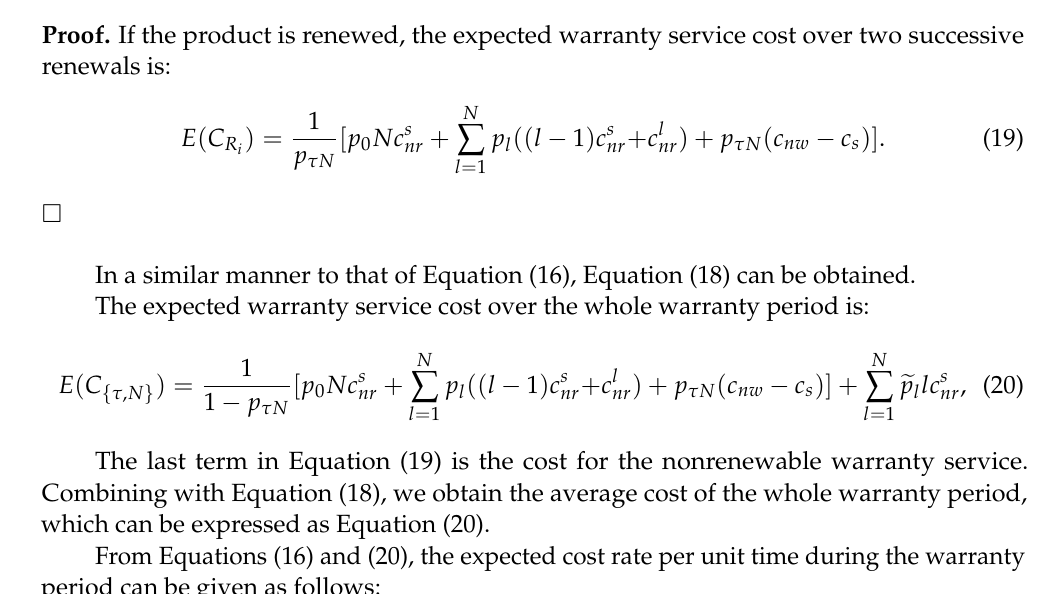
Figure 2. A possible product state evolution path under